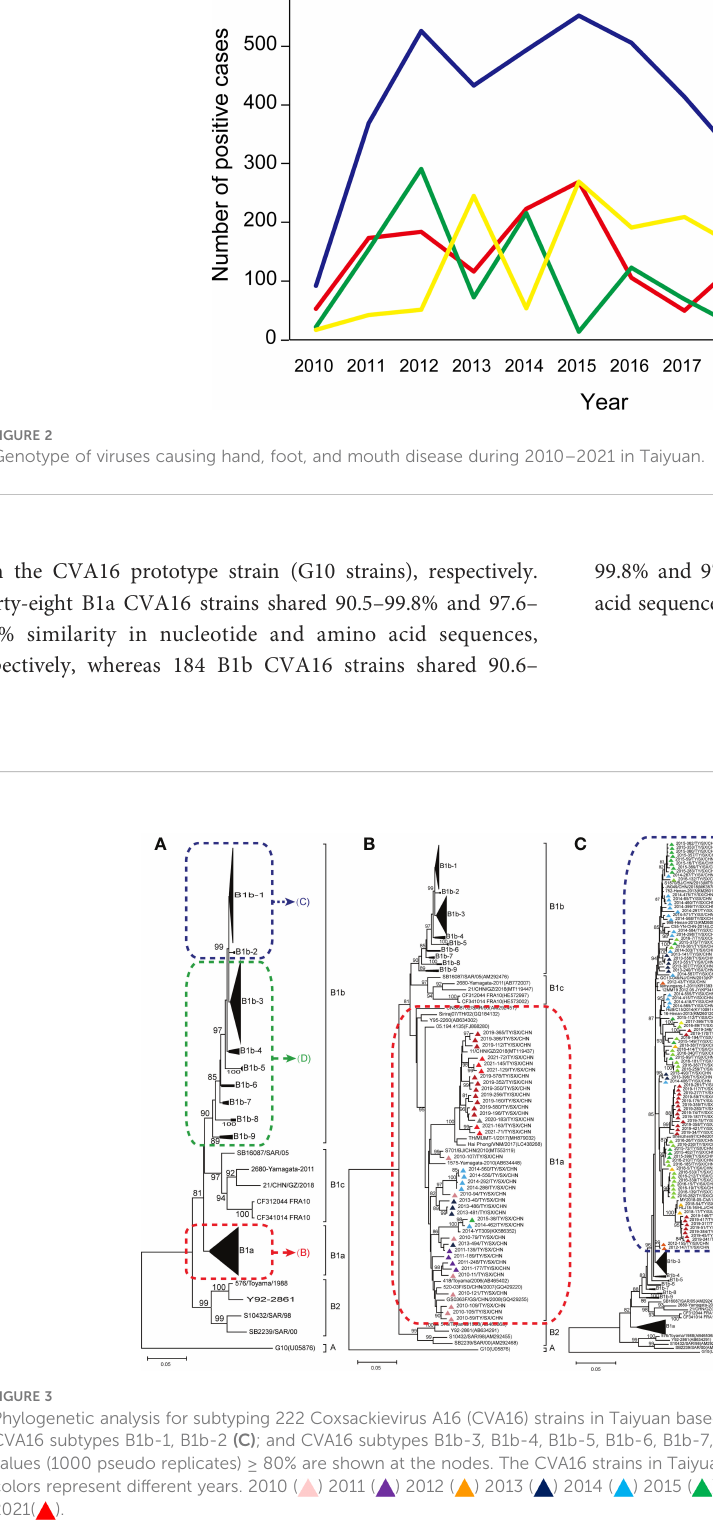
FIGURE 3 Phylogenetic analysis for subtyping 222 Coxsackievirus A16 (CVA16) strains in Taiyuan based on their VP1 sequences (A) ; CVA16 subtype B1a (B) ; CVA16 subtypes B1b-1, B1b-2 (C) ; and CVA16 subtypes B1b-3, B1b-4, B1b-5, B1b-6, B1b-7, B1b-8, and B1b-9 (D) . Percentages of bootstrap values (1000 pseudo replicates) ≥ 80% are shown at the nodes. The CVA16 strains in Taiyuan are represented by triangles. Triangles of different colors represent different years. 2010 ( ) 2011 ( ) 2012 ( ) 2013 ( ) 2014 ( ) 2015 ( ) 2016 ( ) 2017 ( ) 2018 ( ) 2019 ( ) 2020 ( ) 2021(